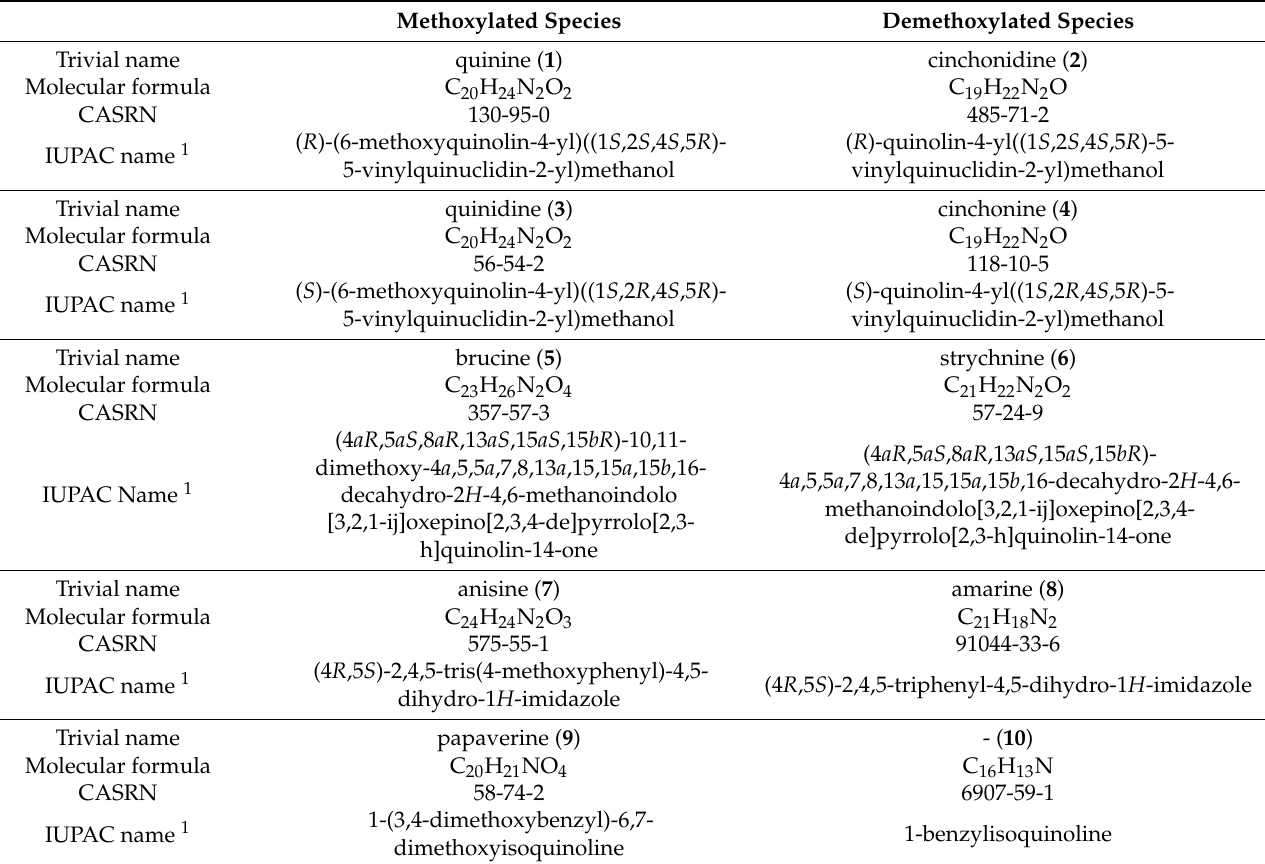
Table 1. Trivial name, molecular formula, CASRN, and IUPAC name of the selected compounds. Methoxylated Species Demethoxylated